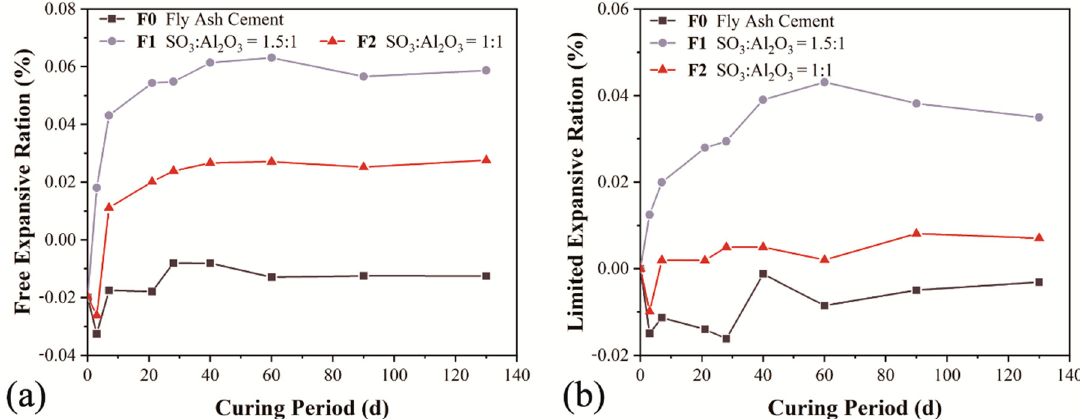
Figure 5. Free expansion ( a ) and limited expansion ( b ) ratio of specimens.